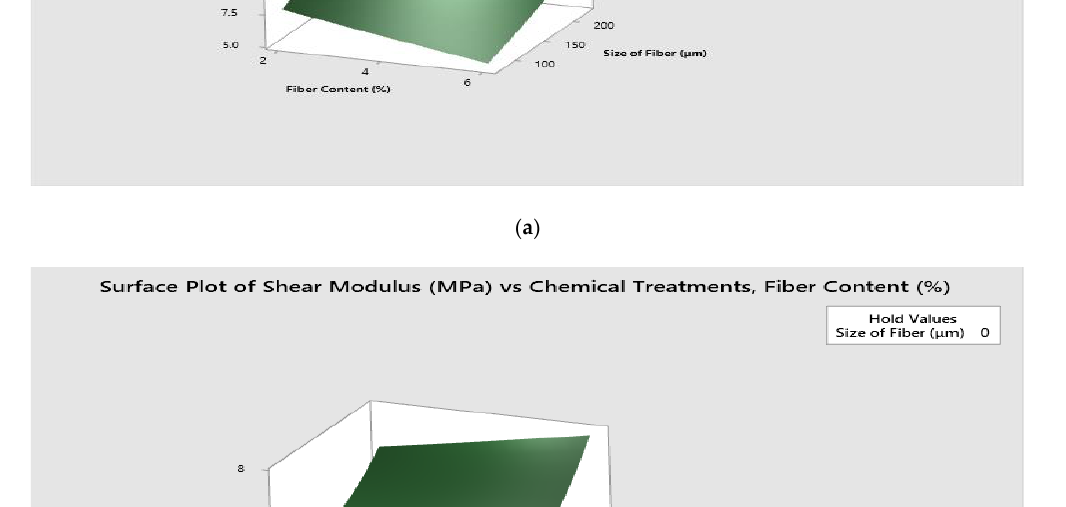
Figure 9. Surface plot for Young’s modulus. ( a ) Surface plot of Young’s modulus (MPa) vs size of fiber ( µ m), fiber content (wt.%) ( b ) Surface plot of Young’s modulus (MPa) vs chemical treatments/fiber content (wt.%). ( c ) Surface plot of Young’s modulus vs. chemical treatments/fiber size ( µ m). Figure 9a explains the surface plot of Young’s modulus vs. fiber size (μm )/fiber con- tent (wt.%). It is palpable that high Young’s modulus is observed for the combination of 2% fiber content and 225 μm fiber size. Figure 9b illustrates the surface plot of Y oung’s modulus vs. chemical treatments /fi- ber content (wt.%). It is inferred that high Young’s modulus is observed for the combina- tion of 6% fiber content and potassium hydroxide treatment. Figure 9c elucidates the surface plot of Young’s modulus vs. chemical treatments/fi- ber size ( μm ). It culminated that a high Young’s modulus was observed for the combina- tion of triethoxy (ethyl) silane treatment and 225 μm fiber size. Figure 10 shows the surface 3D plot of interaction between input parameters such as fiber content (%), fiber size (μm) and chemical treatments on shear modulus.